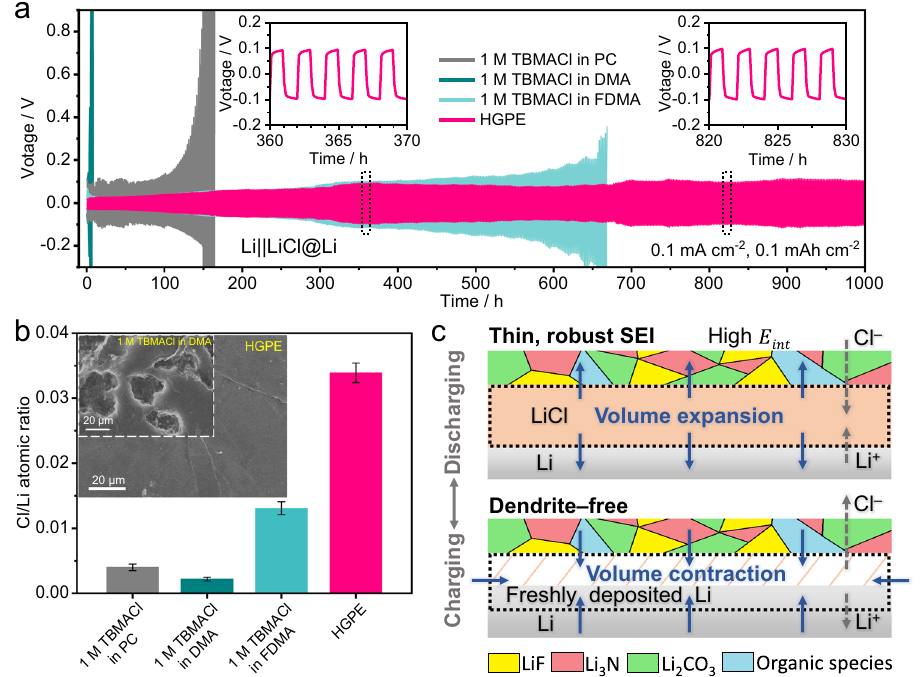
Fig. 5 | Electrochemical and physicochemical characterizations of the Li|elec- trolyteinterphase.a Voltagepro fi leofLi||LiCl@Licellsusingdifferentelectrolytes at0.1mAcm − 2 with a cut-off capacity of0.1mAhcm − 2 . Insets are enlarged portions of 360 – 370h and 820 – 830h for the Cl-ion-conducting HGPE-based cell. b Cl/Li atomicratioderivedfromtheexsituXPSspectraandexsituFE-SEMimages(shown